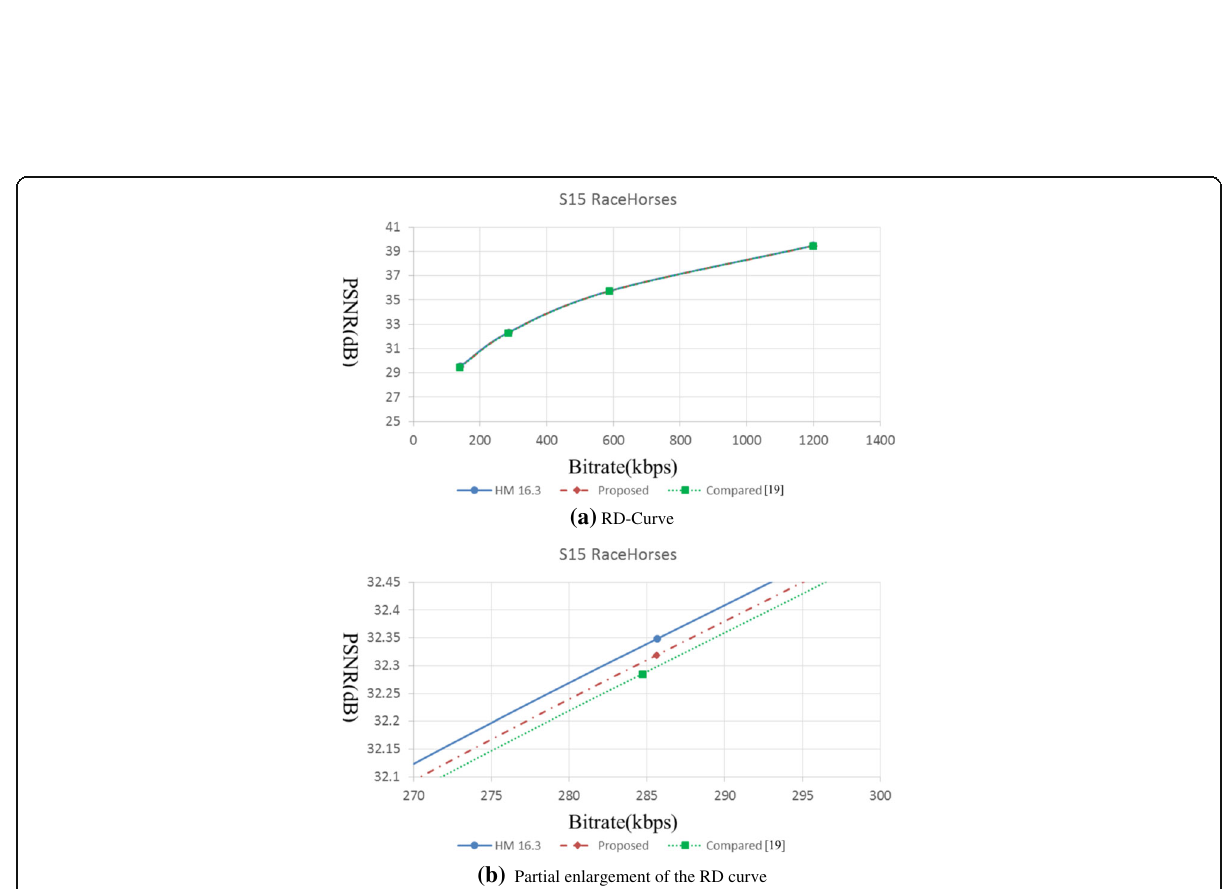
Fig. 19 RD-curve comparison of S15 (RaceHores) under random-access configuration. ( a ) RD-curve. ( b ) partial enlargement of the